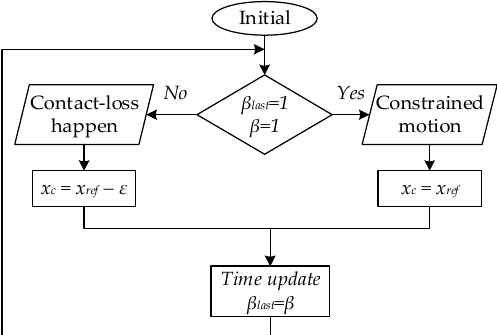
Figure 4. The flowchart of fading function for smoothing trajectory.